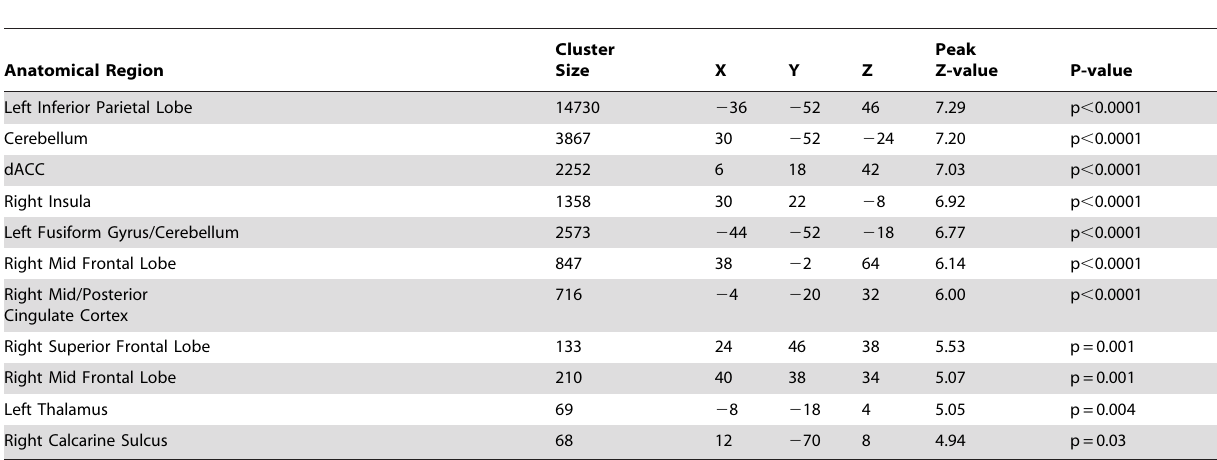
Table 2. Representation of cerebral activation when contrasting incongruent . congruent stimuli for FM patients and HC together.